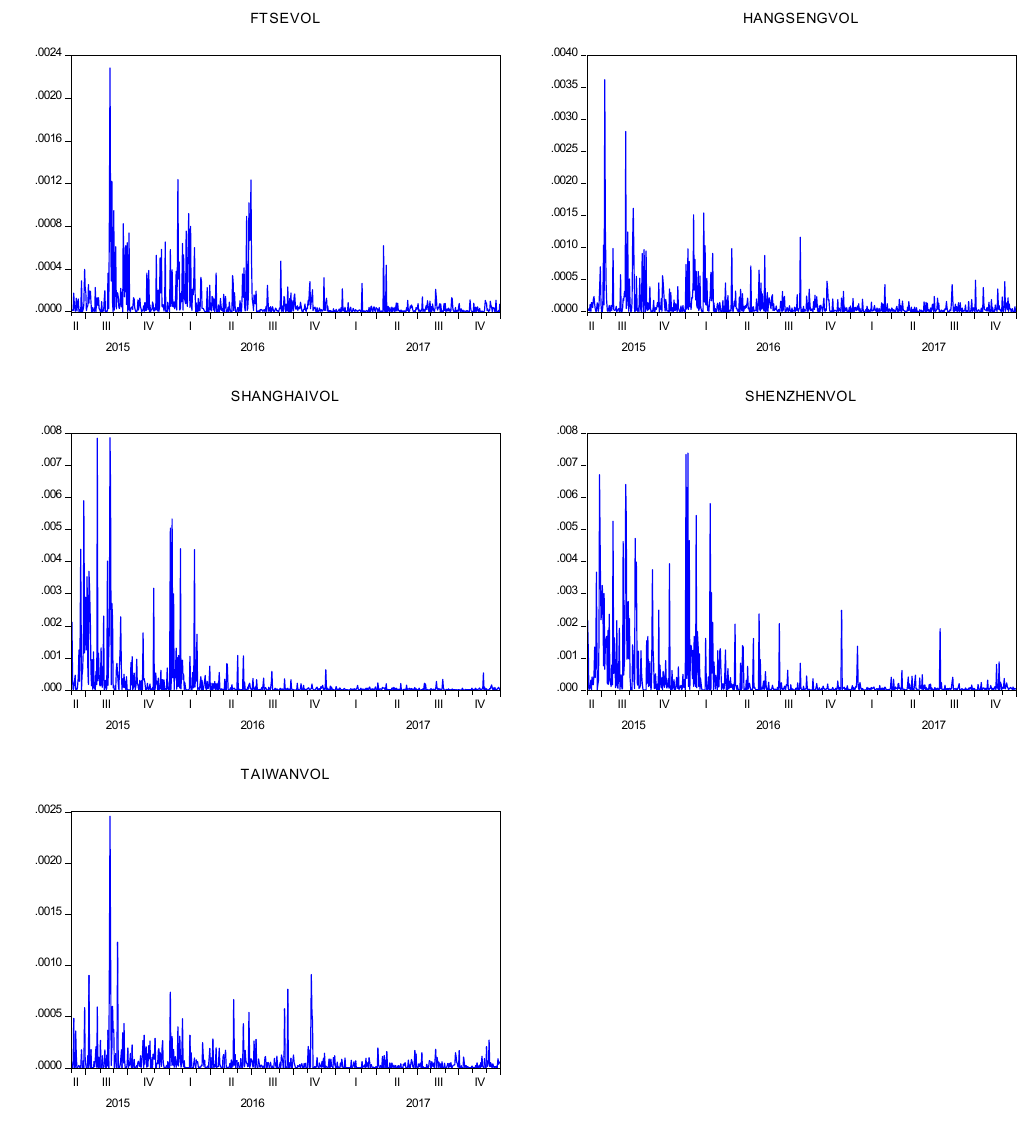
Figure A3. Historical Volatility—post Brexit. Table A1. Residual Tests: OLS estimation.